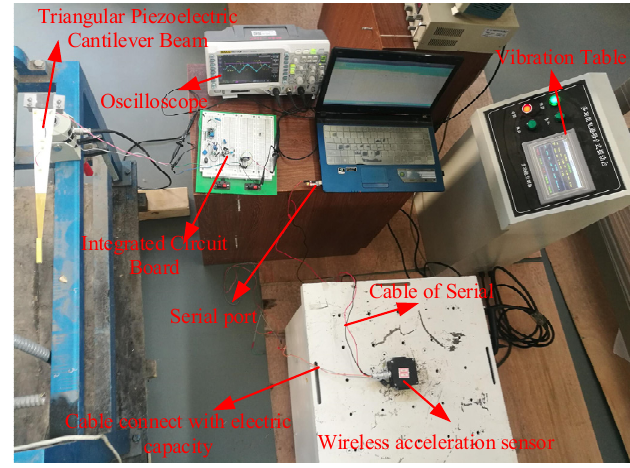
Figure 27. The self-powered performance test of sensor.